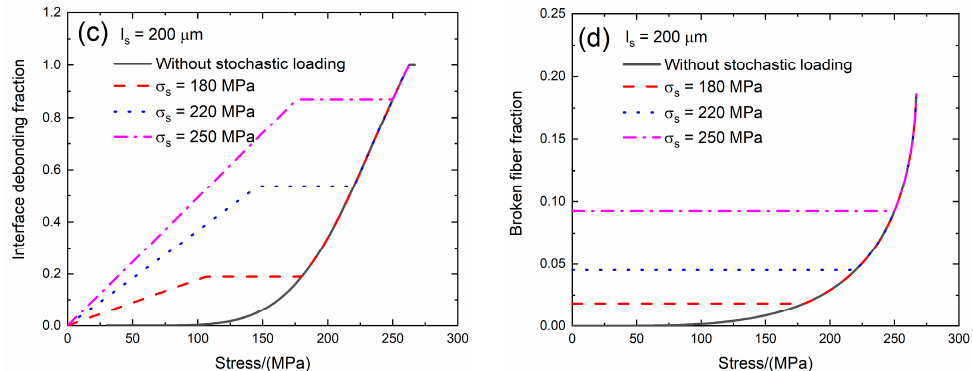
Figure 9. ( a ) The tensile stress–strain curves; ( b ) the tangent modulus versus strain curves; ( c ) the interface debonding fraction versus stress curves; and ( d ) the broken fibers fraction versus stress curves of SiC/SiC composite for conditions without stochastic loading and with stochastic loading of σ s = 180, 220 and 250 MPa when l s = 200 μ m.